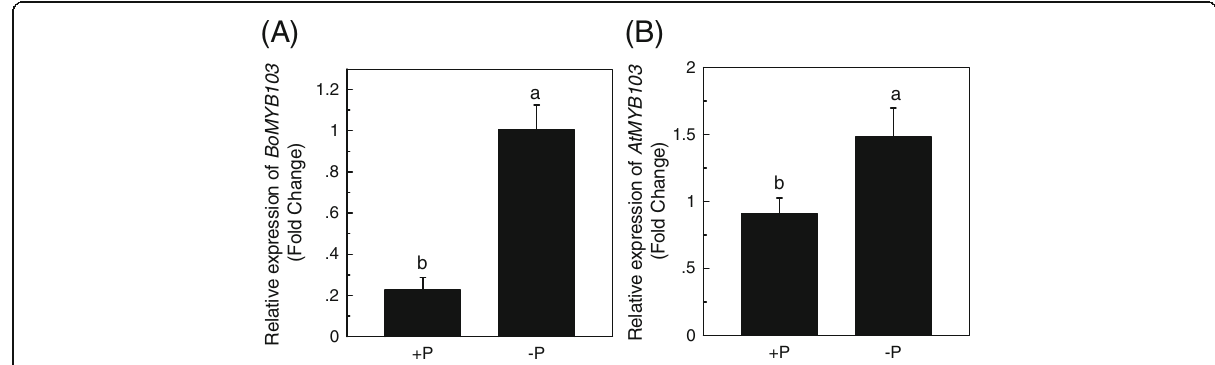
Fig. 1 Relative expression of MYB103 in response to P deficiency in Arabidopsis thaliana and Brassica oleracea . Seedlings were hydroponically treated with +P or -P solution for 7 d, and the expression of MYB103 was measured in B. oleracea ( a ) and A. thaliana ( b ) respectively. Values are means ± SD, n = 4. Different letters on the bars indicate significant differences at p <